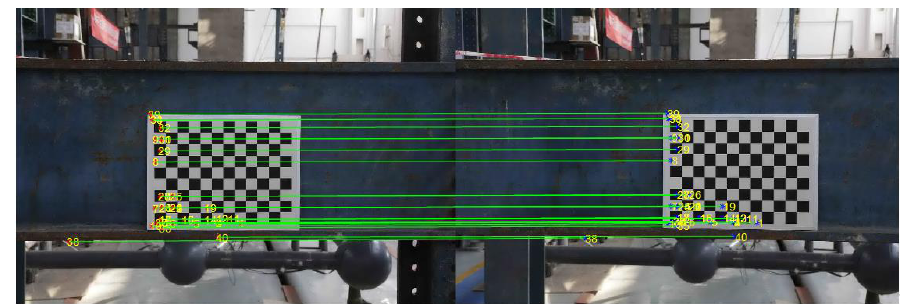
Figure 2. Registration of feature